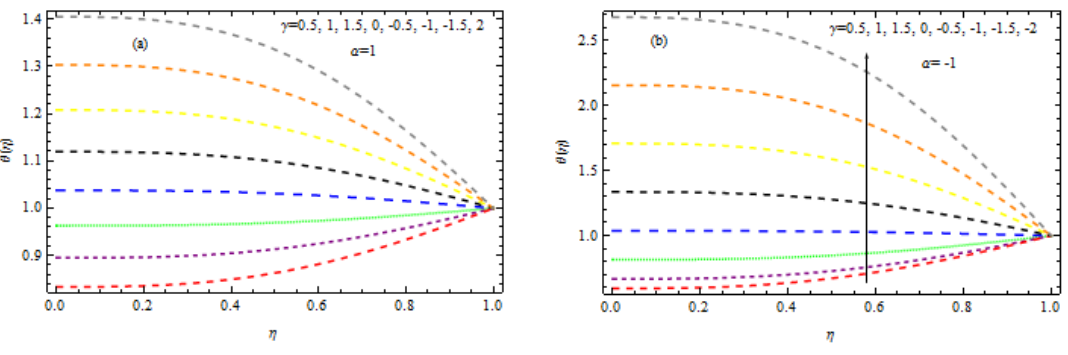
Figure 17. ( a , b ) Influence of 𝛾 on temperature.